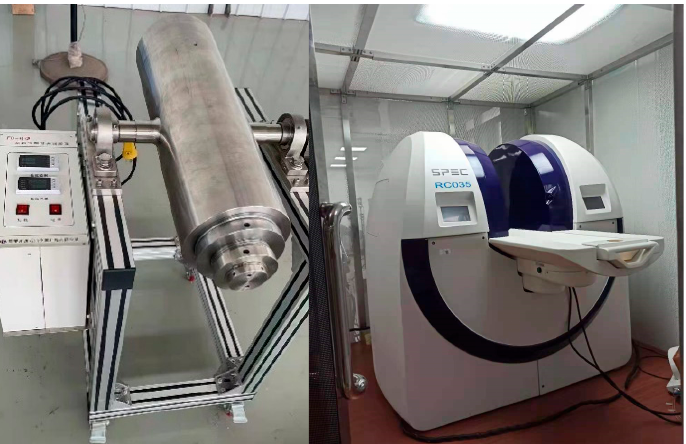
Figure 2. Full-diameter core holder (upper left) and Spec-RC035 large NMR scanner (upper right).